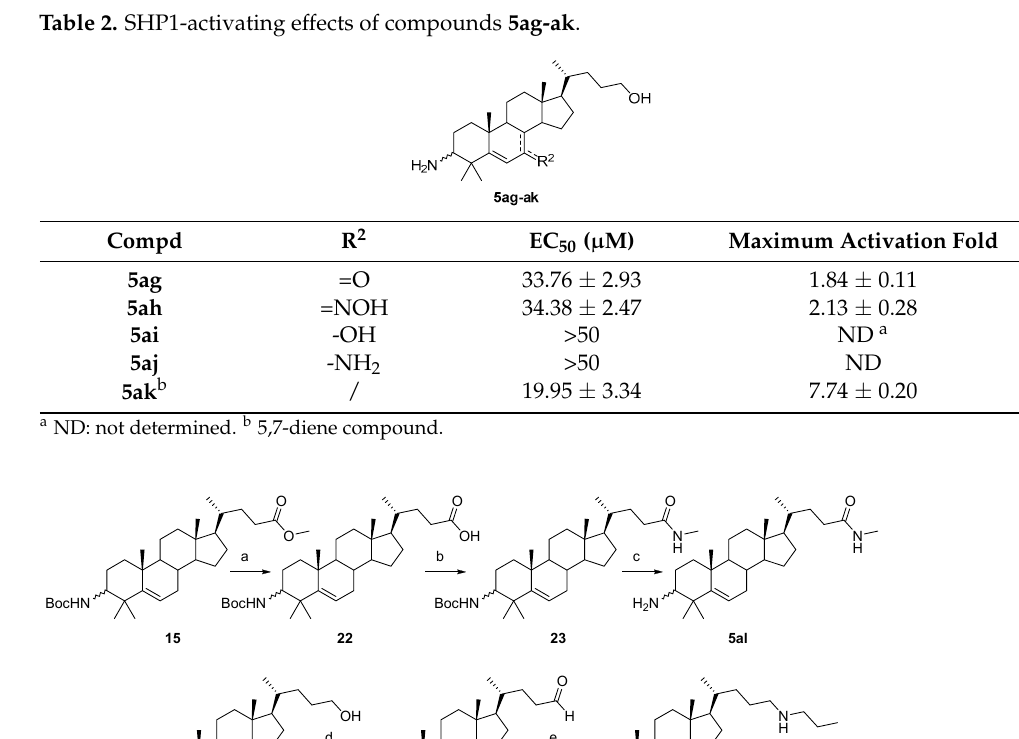
Table 2. SHP1-activating effects of compounds 5ag-ak